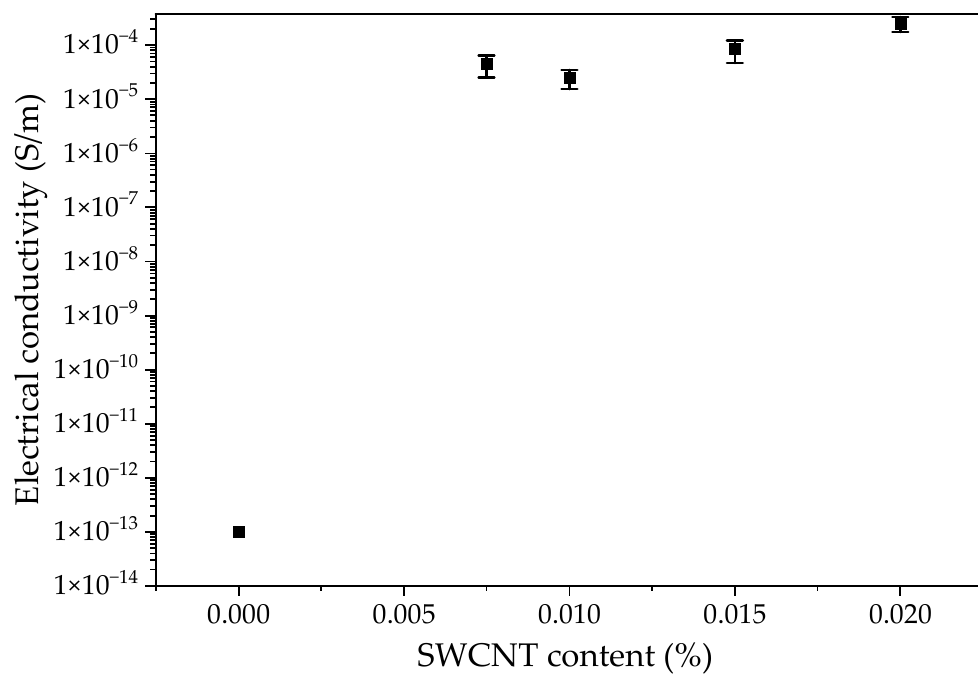
Figure 2. Electrical conductivity of Elium ® /SWCNT nanocomposites.